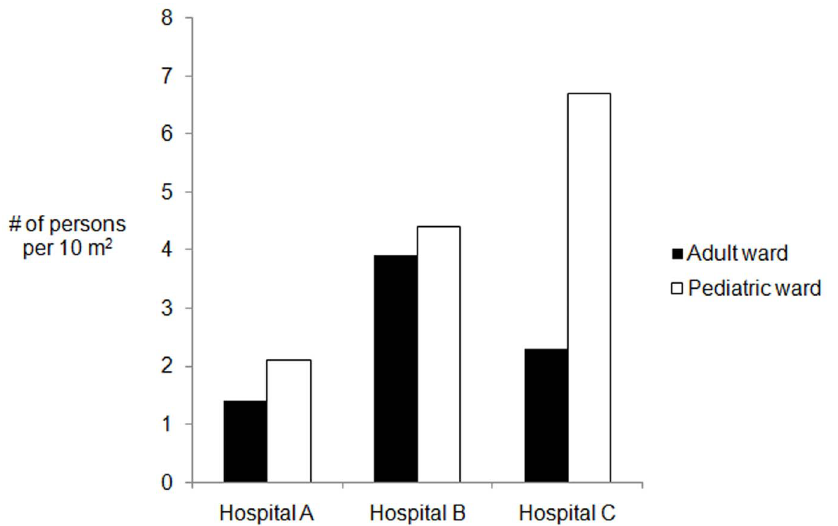
Figure 1. Median people present per 10 m 2 by type of ward in three hospitals, 2007. Detailed legend: Median number of people present per 10 m 2 by type of ward of the three hospitals, 2007.